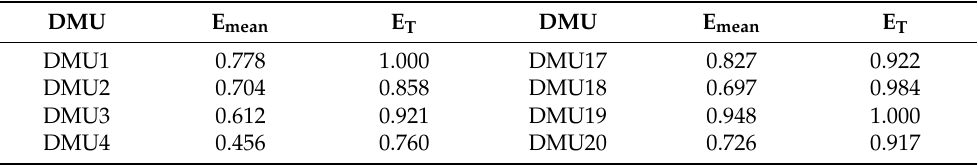
Table 8. A comparison of the efficiency results predicted for 31 branches of an insurance company, with the average efficiency of the branches throughout the